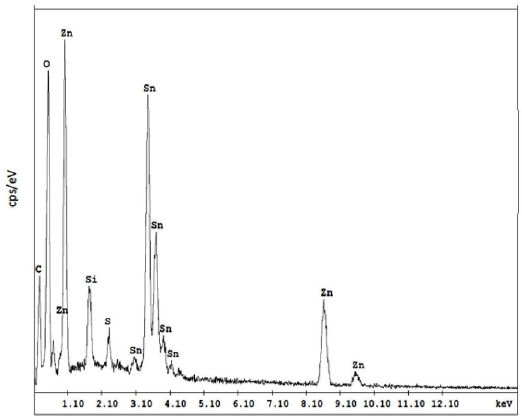
Figure 5: EDX pattern of 5% Sn: ZnS.